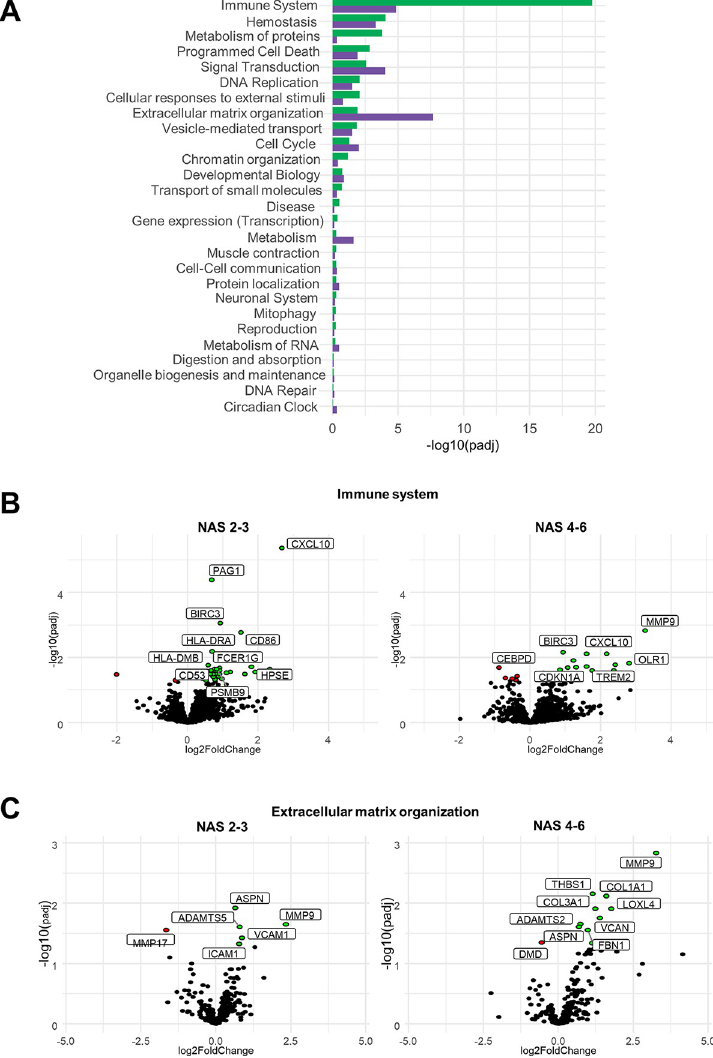
Fig 3. Progression of NAFLD is accompanied by a change in immune system and extracellular matrix organization pathways. (A) Overview of differentially regulated Reactome pathways (log10 of false discover rate) in individuals with NAS 2–3 and NAS 4–6 as compared to individuals with no/mild NAFLD (NAS 0–1). (B, C) Volcano plots illustrating DEGs in selected Reactome pathways, i.e., immune system and extracellular matrix organization Reactome pathways compared to individuals with no/mild NAFLD (NAS 0–1). Significantly regulated genes ( p < 0.05) are indicated in red (downregulation) and green (upregulation), respectively. Abbreviations: DEGs, differentially expressed genes; NAFLD; non-alcoholic fatty liver disease; NAS, NAFLD activity